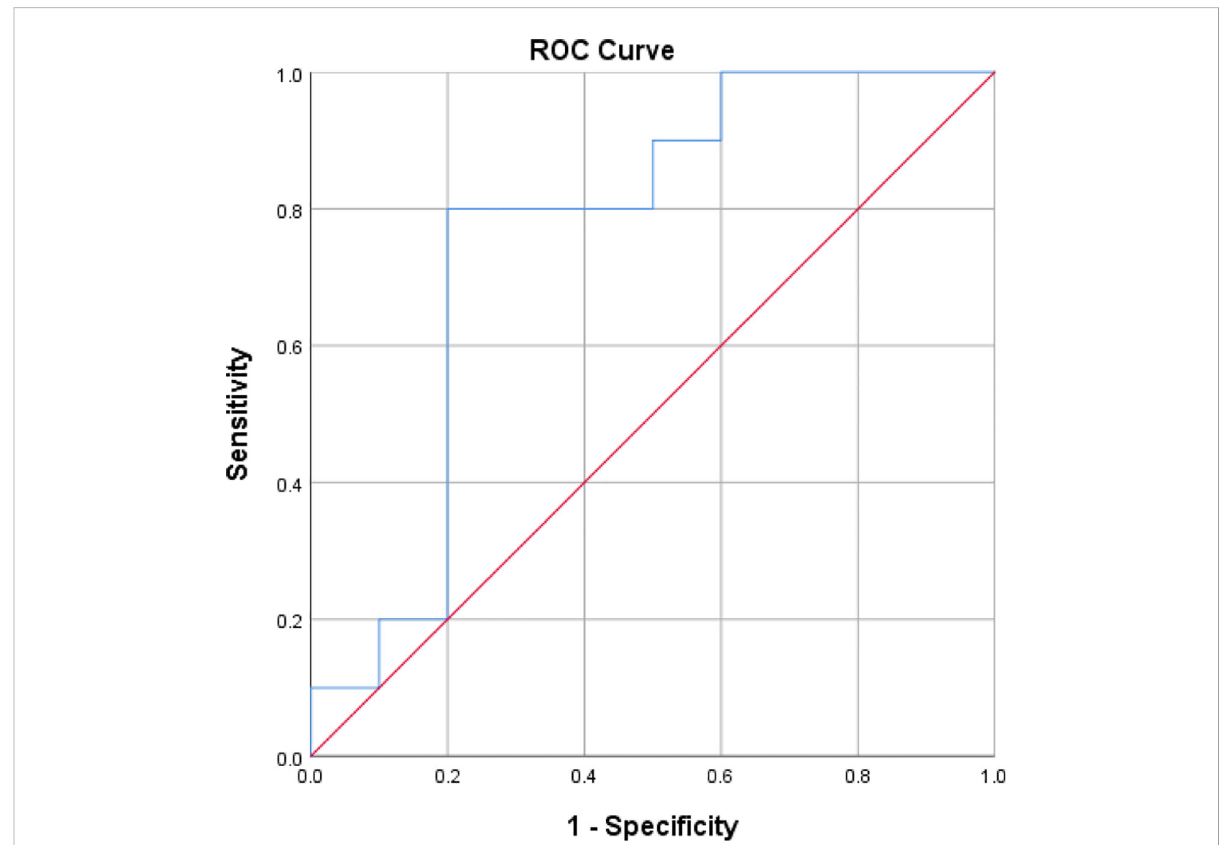
FIGURE 3 The Receiver operating characteristic(R.O.C.) curve for determining the optimal STL cut-off value for the diagnosis of male